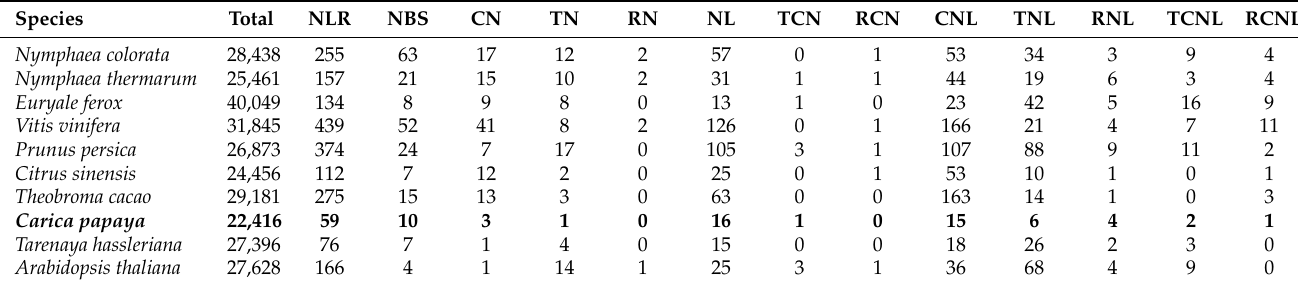
Table 1. The number of NLRs identified in papaya and selected